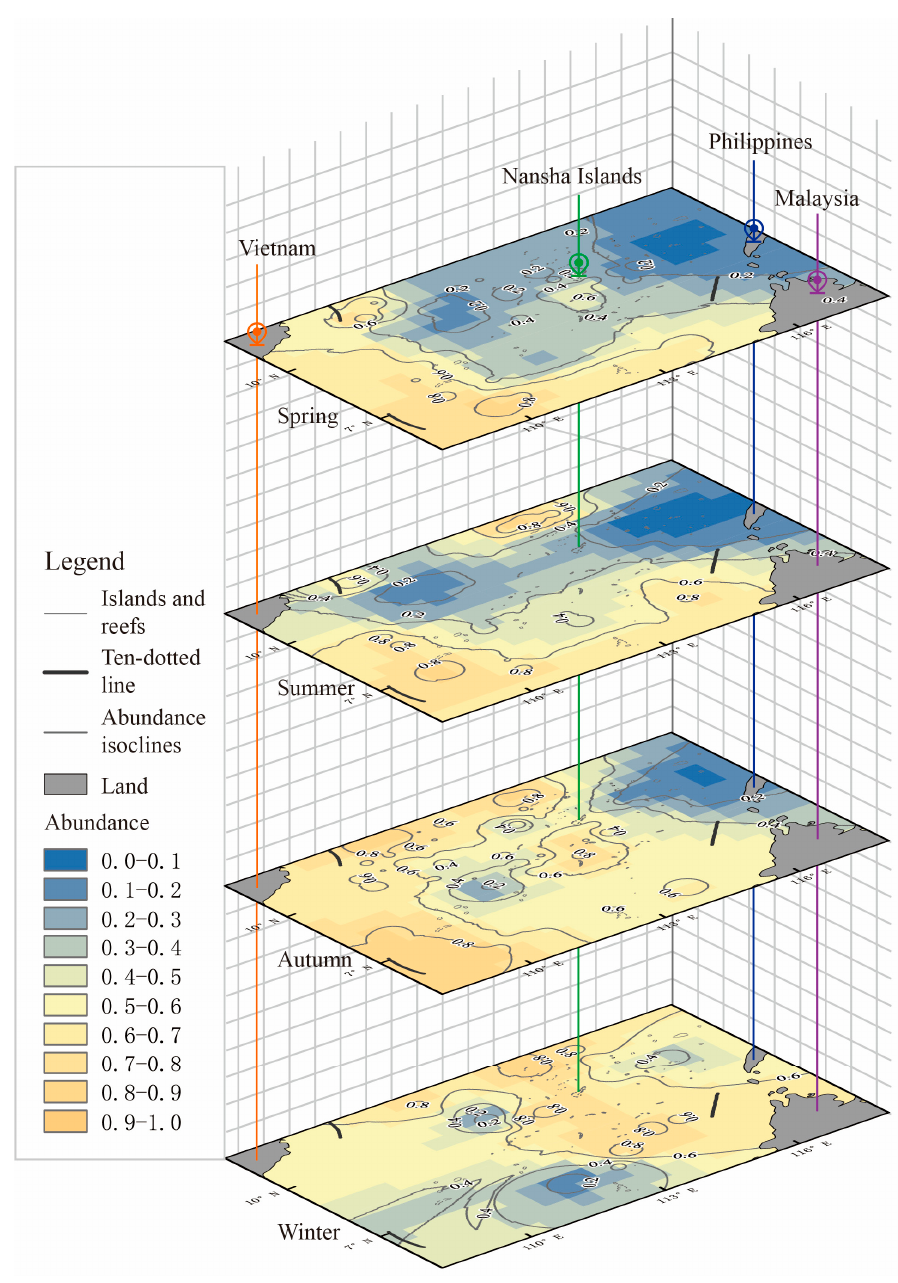
Figure 7. Seasonal distribution of fishing grounds of S. oualaniensis in the Nansha Islands.